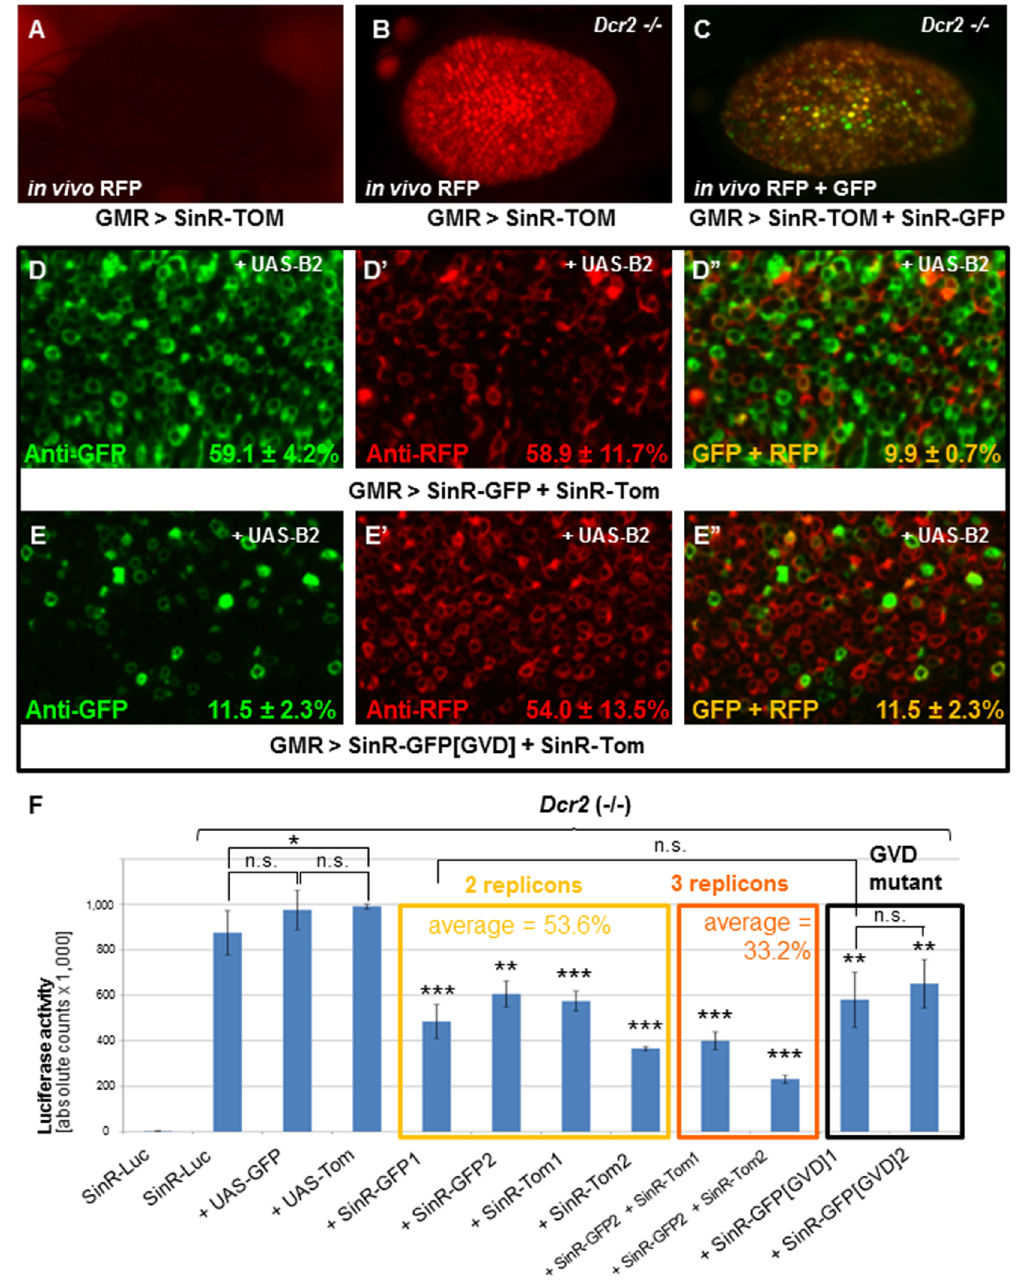
Figure 5. Stochastic exclusion between transgenic replicons. A. Expression of red fluorescent, replication-competent replicon SinR-Tom was undetectable when driven in the adult eye using GMR-GAL4, with the RNAi pathway intact. B. Strong levels of Tomato expression from SinR-TOM observed in homozygous Dcr2 mutants. C. Strong red and green fluorescence in flies co-expressing both SinR-GFP and SinR-TOM in Drc2 mutants. Note that not all ommatidia co-expressed the two replicons. D. Third instar larval eye discs dissected from flies co-expressing SinR-GFP, SinR-TOM, and UAS-B2 under GMR-GAL4 control. Strong co-expression was observed only in , 10% of ommatidia. Apparently, the two replicons exclude each other’s expression. E. Third instar larval eye discs co-expressing replication-deficient SinR-GFP[GVD] and SinR-TOM revealing a similarly low degree of GFP trans-activation. In these cases, the two proteins always co-localized, as expected. F. Quantification of in vivo replicon exclusion using SinR-Luc. In homozygous Dcr2 mutants, SinR-Luc activity was not affected by co-expression of either UAS-mCD8GFP, or UAS-myr:Tomato. However, co- expression of different insertions of SinR-GFP (suffix 1 and 2) or SinR-Tom all reduced Luciferase levels by approximately half ( 2 46.7%). Moreover, expression of all three replicons in Dcr2 mutants lowered the Luciferase counts by approximately two thirds ( 2 66.8%). Interestingly, co-expression of replication-deficient SinR[GVD]-GFP, also reduced Luciferase activity ( 2 30%). doi:10.1371/journal.pone.0112092.g005 transactivation). Thus, co-expression of two replication-competent control, we stained eye imaginal discs co-expressing UAS- replicons within the same cell occurred at the same low rate than mCD8:GFP and UAS-myr:Tomato (Figure S5G). As expected, trans-activation of a replication-deficient replicon. Finally, as a the fluorescent proteins always co-localized in every cell.